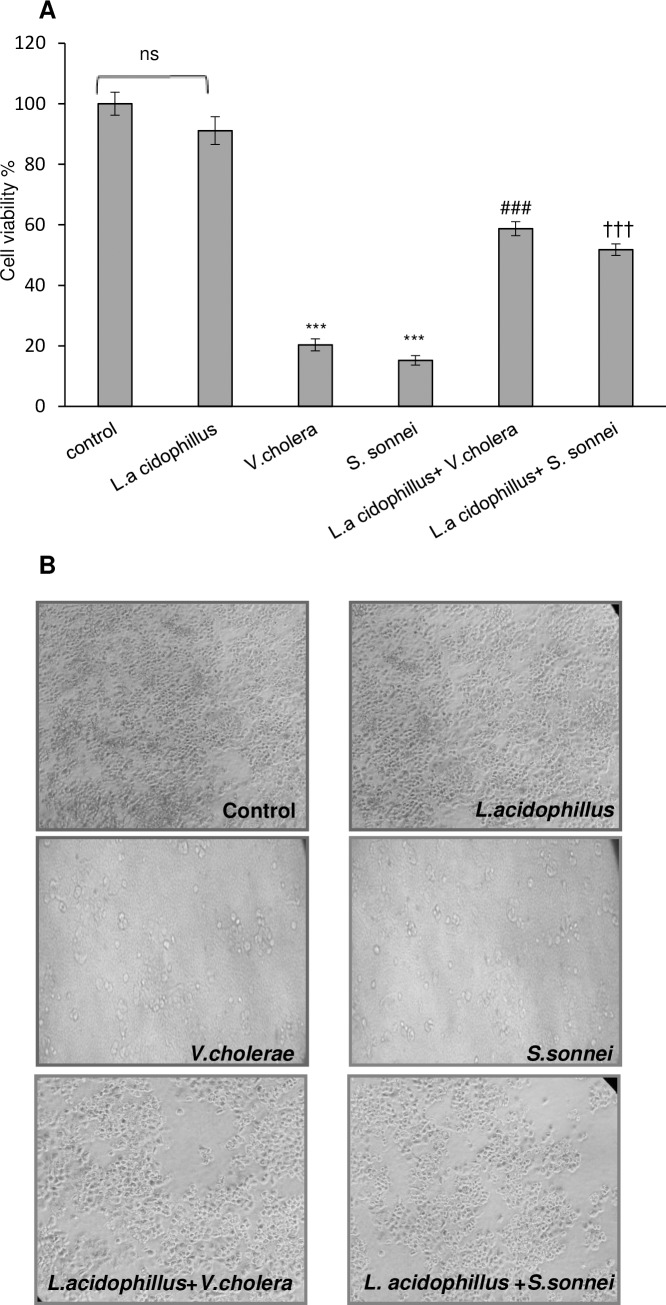
The effect of V. cholerae, S. sonnei and L. acidophilus on cell viability.(A) cell viability of Caco-2 cells infected by V. colarae/ S. sonnei was determined by MTT assay, Each value represents the mean ±SEM (n = 3). ***p < 0.001 compared with control (untreated Caco-2cells) by one way ANOVA with Tukey’s post hoc test. ###p < 0.001 significantly different of L.a+V.c+Caco-2 group from V.c+Caco-2 group. †††p < 0.001 significantly different between L.a+S.s+Caco-2 group with S.s+Caco-2 (by unpaired two-tailed Student’s t test). All experiments were repeated three times. L.a: Lactobacillus acidophilus, V.c: Vibrio cholerae and S.s: Shigella sonnei, ns: none significant. (B) Morphological evaluation of Caco-2 cells under the above-mentioned treatment by light microscopic observation. L.a: Lactobacillus acidophilus, V.c: Vibrio cholerae and S.s: Shigella sonnei.